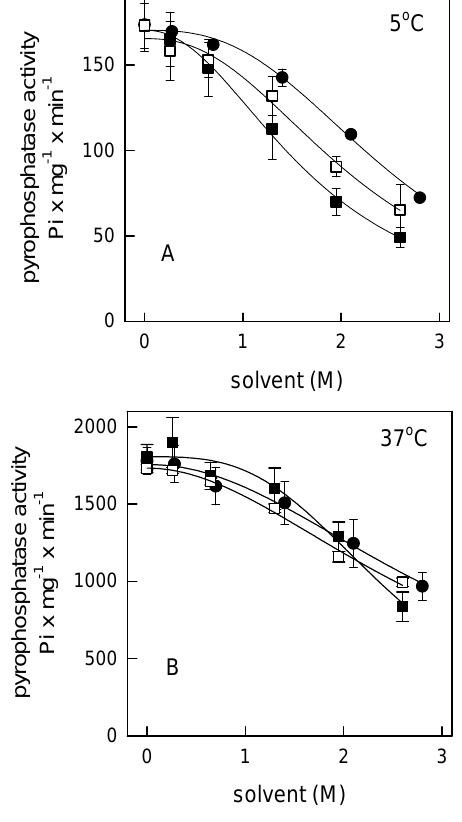
Fig. 2 – Inactivation of yeast inorganic pyrophosphatase by 3- carbon organic solvents. Reaction was performed as described under Materials and Methods at 5 ◦ C (panel A) and 37 ◦ C (panel B) in the presence of the concentrations of 1-propanol ( (cid:1) ), 2- propanol ( (cid:2) ) and acetone ( • ) indicated on abscissa. Data points represent means ± SE of four independent experiments (n =